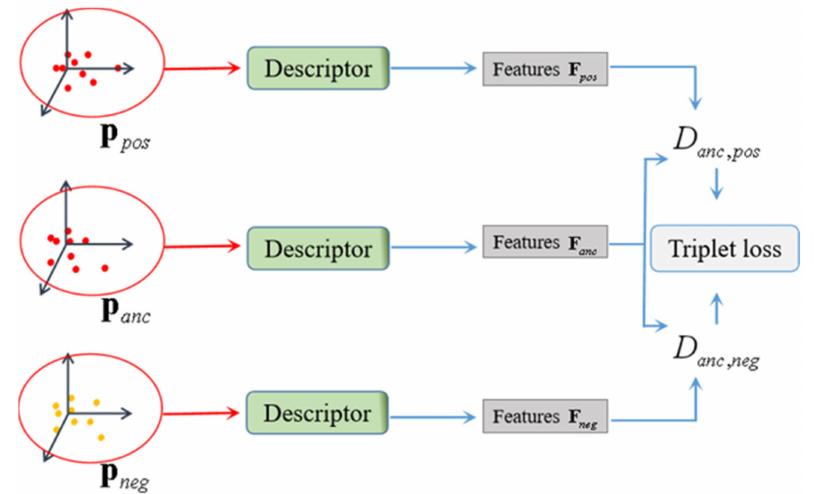
Figure 3. The construction process by the triplet